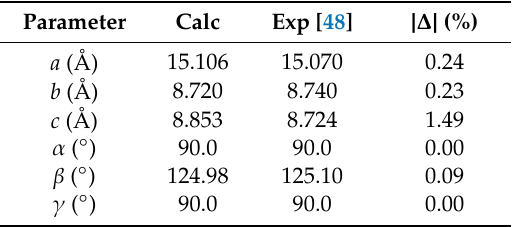
Table 1. Comparison of experimental and calculated values of monoclinic ( C 2 / c ) Na 3 Fe 2 (PO 4 ) 3